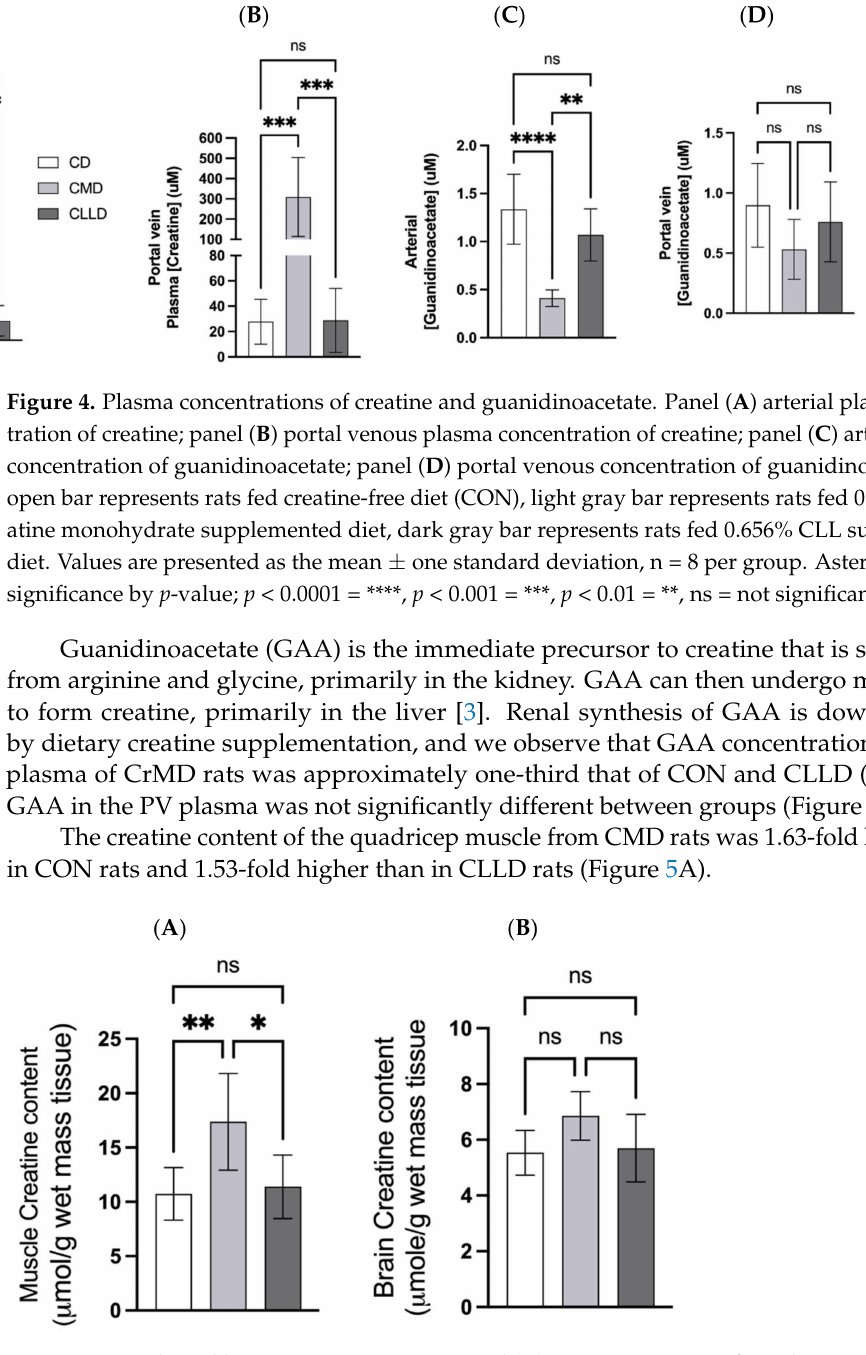
Figure 5. Muscle and brain creatine content. Panel ( A ) Creatine content of quadricep muscle; panel ( B ); creatine content of whole brain. The open bar represents rats fed creatine-free diet (CON), light gray bar represents rats fed 0.4% w / w creatine monohydrate-supplemented diet, dark gray bar represents rats fed 0.656% CLL supplemented diet. Values are presented as the mean ± one standard deviation, n = 8 per group. Asterisks indicate significance by p -value; p < 0.01 = **, p < 0.05 = *, ns = not